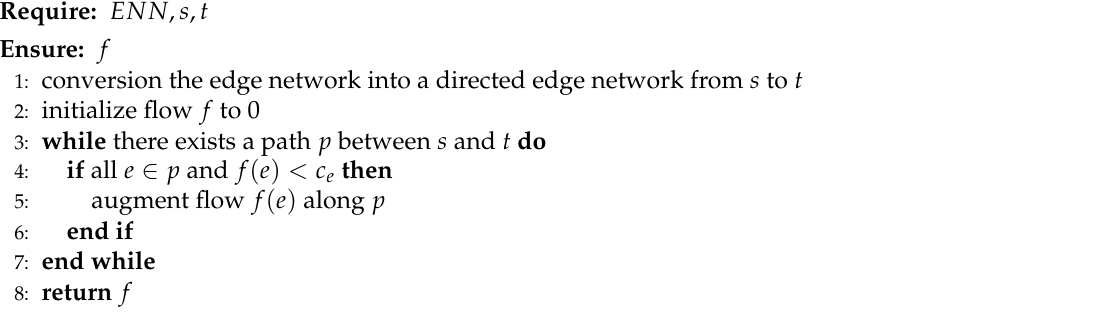
Algorithm 1 Network Maximum